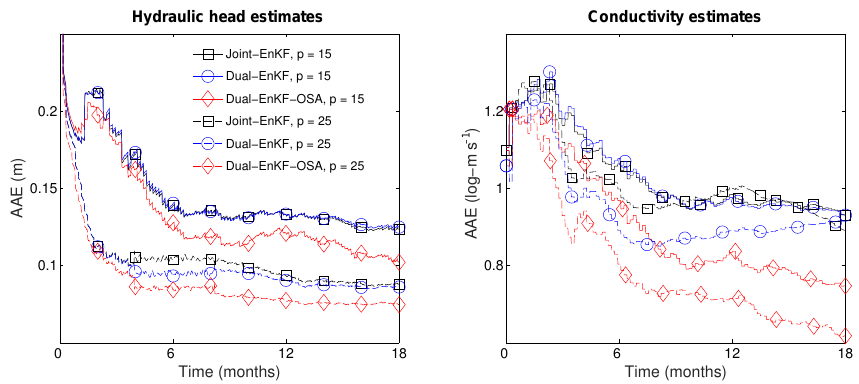
Figure 7. Time series of AAE of hydraulic head (left panel) and conductivity (right panel) using the joint EnKF, dual EnKF, and dual EnKF OSA schemes. Results are shown for two scenarios in which assimilation of hydraulic head data are obtained from 15 and 25 wells (uniformly distributed throughout the aquifer domain) every 5 days. The four experimental scenarios use 100 ensemble members and 0.10m as the measurement error standard deviation. The number of wells is denoted by p